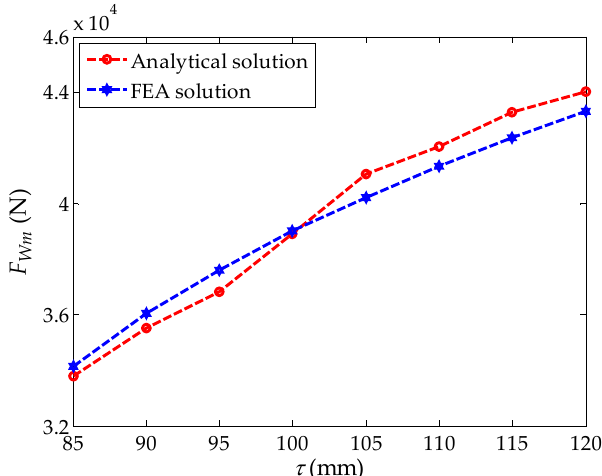
Figure 9. The peak braking force varying with the pole pitch.